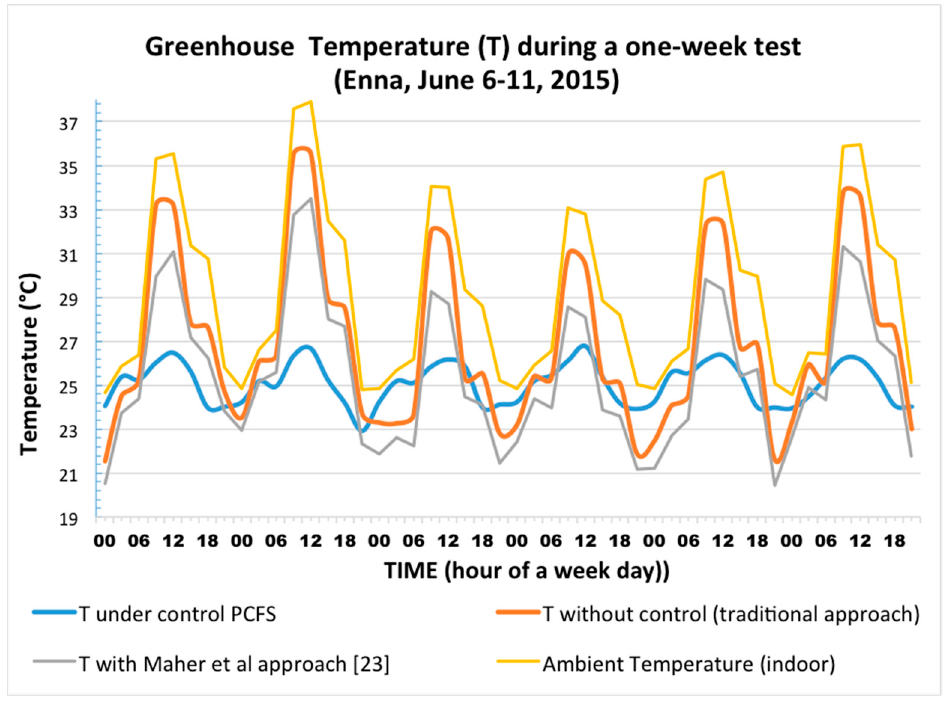
Figure 8. Greenhouse temperature (summer week).